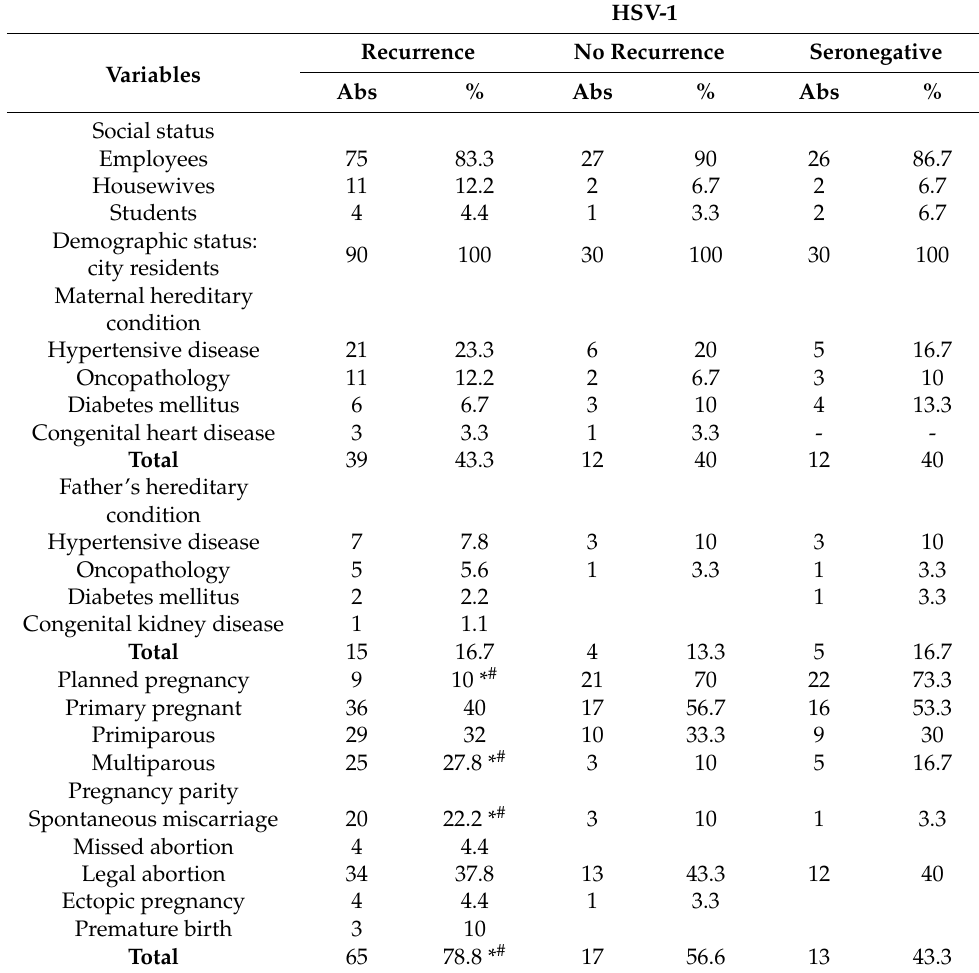
Table 5. Socio-demographic characteristics and pregnancy parity in the study